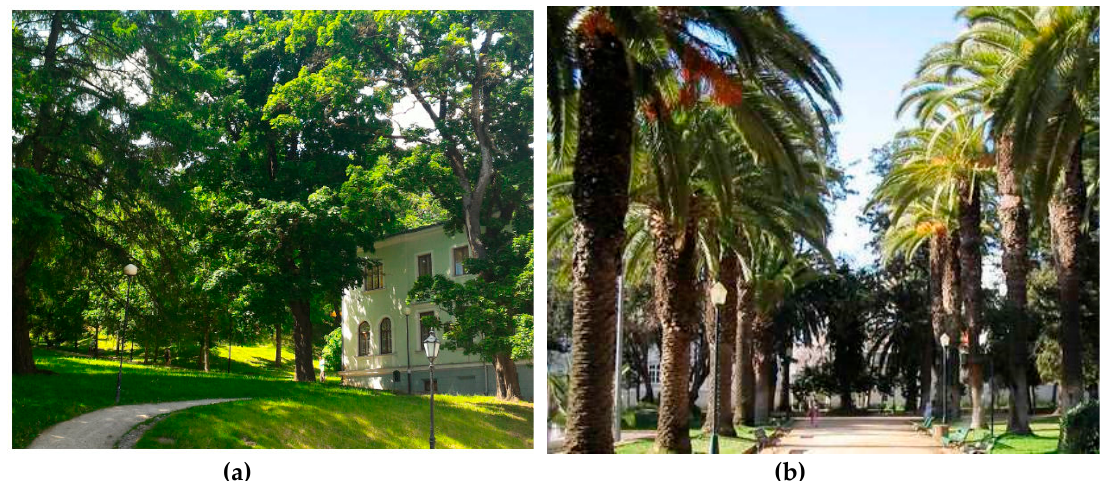
Figure 3. Toomemägi in Tartu ( a ) and Alameda garden in Faro ( b ). Image from field survey by authors.